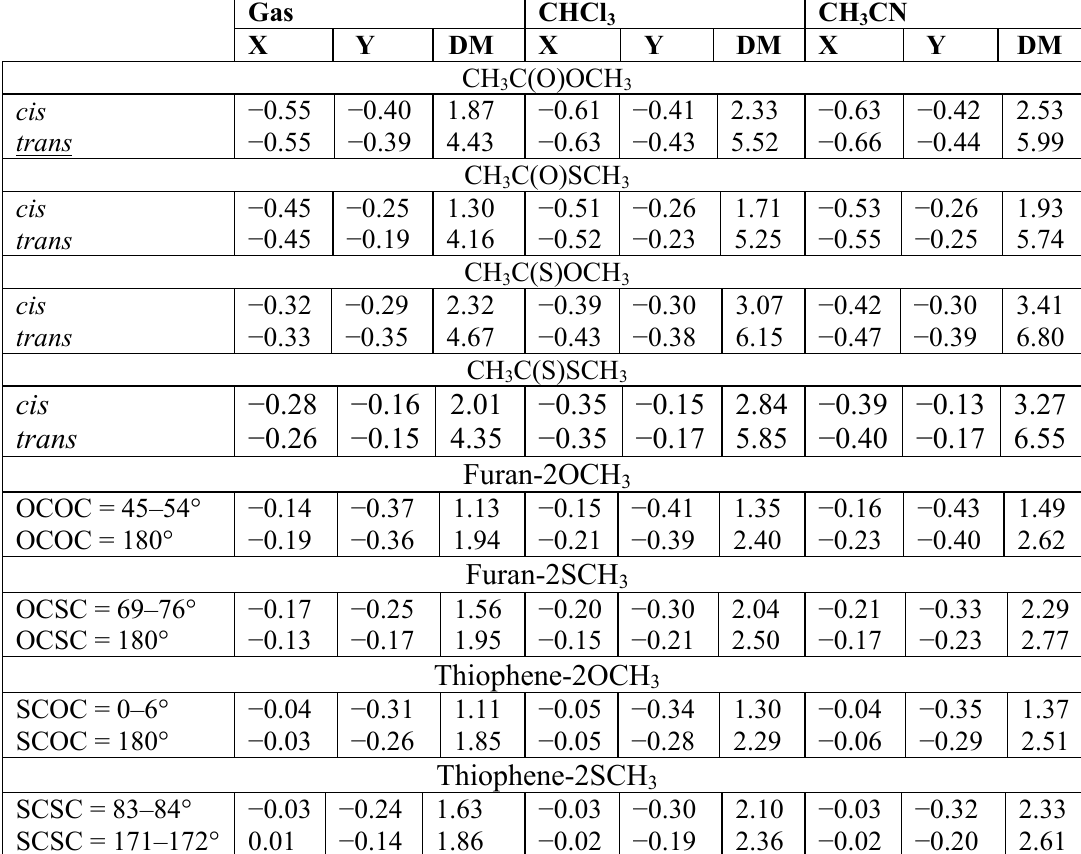
Table 6. Net atomic charges fitted to the B97D/aug-cc-pv(t+d)z molecular electrostatic potential by means of the CHELPG procedure a